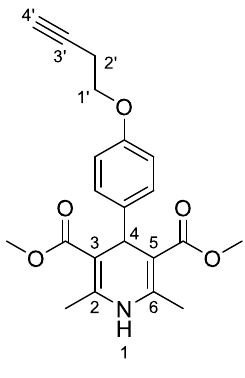
Figure 12. Chemical stucture of 3k .